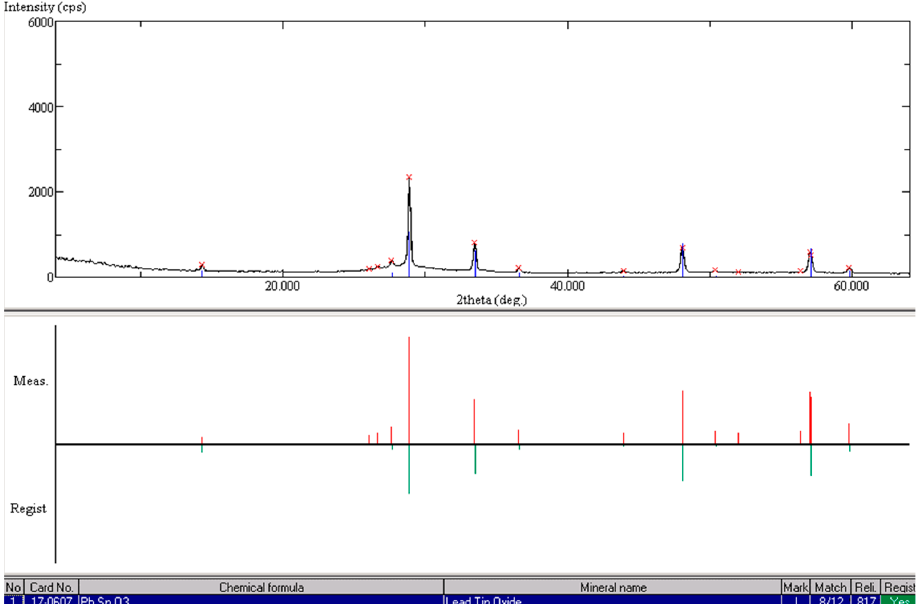
Figure 35. X-ray diffraction pattern showing a close match between the yellow-colored tesserae with Pb–Sn-based phases and PbSnO 3 (DMS_2Bb yellow natron-based Egypt I glass tessera from the Great Mosque of Damascus, Syria—unpublished data [24,25]).